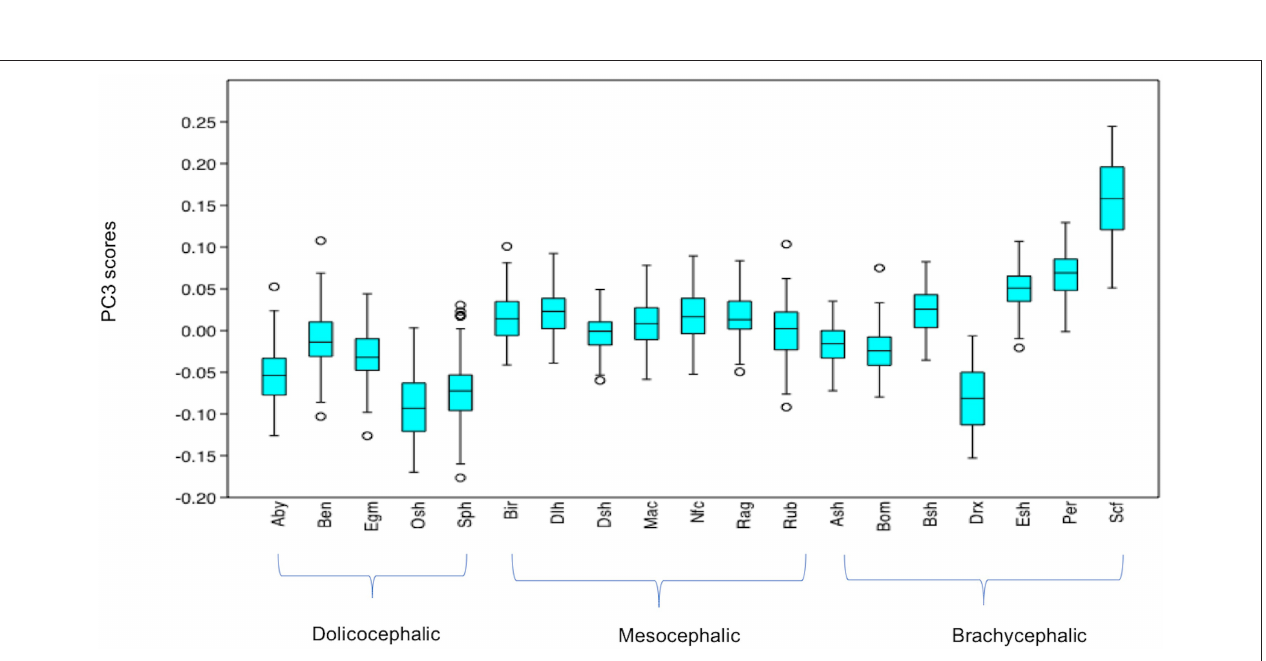
FIGURE 7 | Boxplot with minimum, first quartile, median, third quartile and maximum values and outliers for PC3 scores for each breed, n = 1,888. Abbreviations for breeds within each cephalic type as follows. Dolichocephalic: Aby, Abyssinian; Ben, Bengal; Egm, Egyptian Mau; Osh, Oriental Shorthair; Sph, Sphynx. Mesocephalic: Bir, Birman; Dlh, Domestic Longhair; Dsh, Domestic shorthair; Mac, Main Coon; Nfc, Norwegian Forest cat; Ragdoll, Russian Blue. Brachycephalic: Ash, American Short hair; Bom, Bombay; Drx, Devon Rex; Esh, Exotic Short hair; Per, Persian; Scf, Scottish fold. For full results of Man Whitney U -tests see Supplementary Data 5 . For shape changes associated with higher PC3 scores, see Figure 1